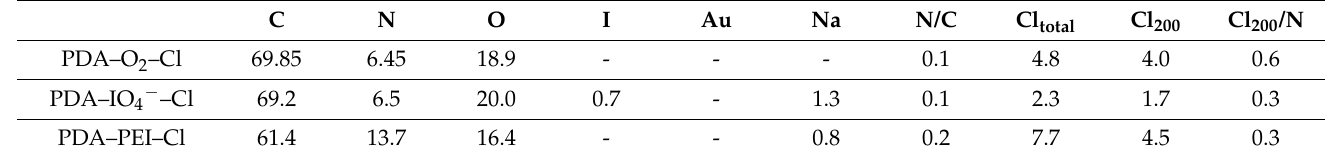
Table 2. Atomic percentage and ratio obtained from XPS data for PDA coatings after chlorination. C